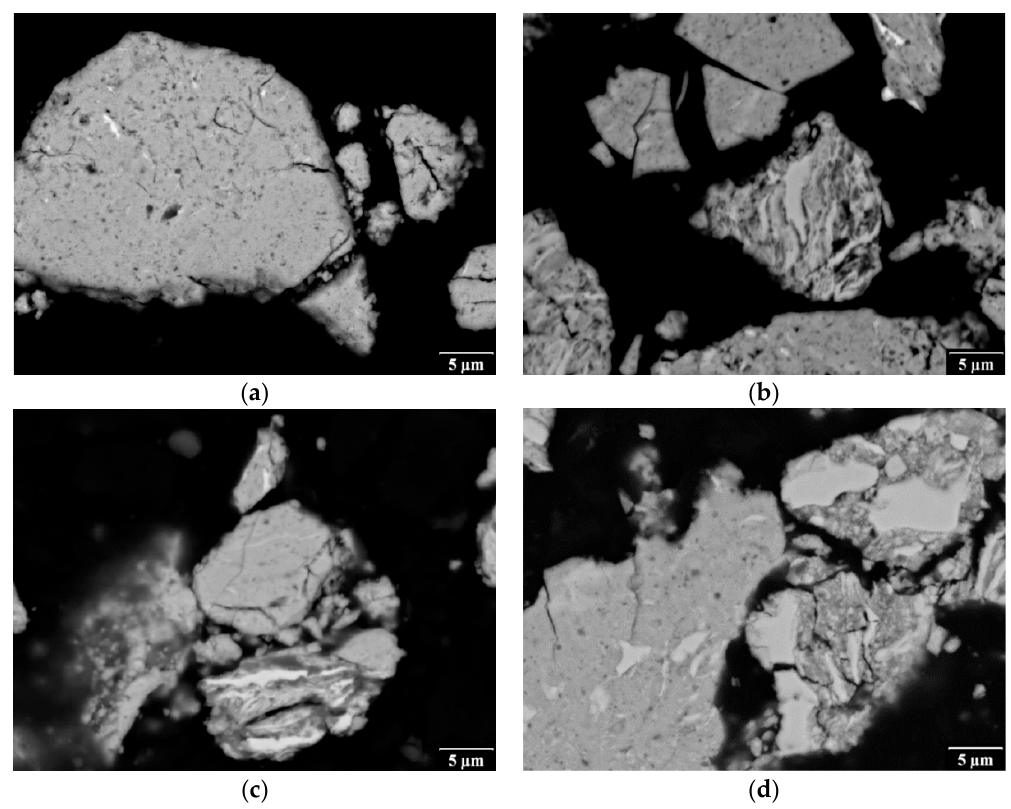
Figure 4. SEM BSE micrographs of powders after 4 h of mechanical alloying: ( a ) Fe_Al_Si, ( b ) FeAl_Si, ( c ) Fe_AlSi, ( d ) FeSi_Al.